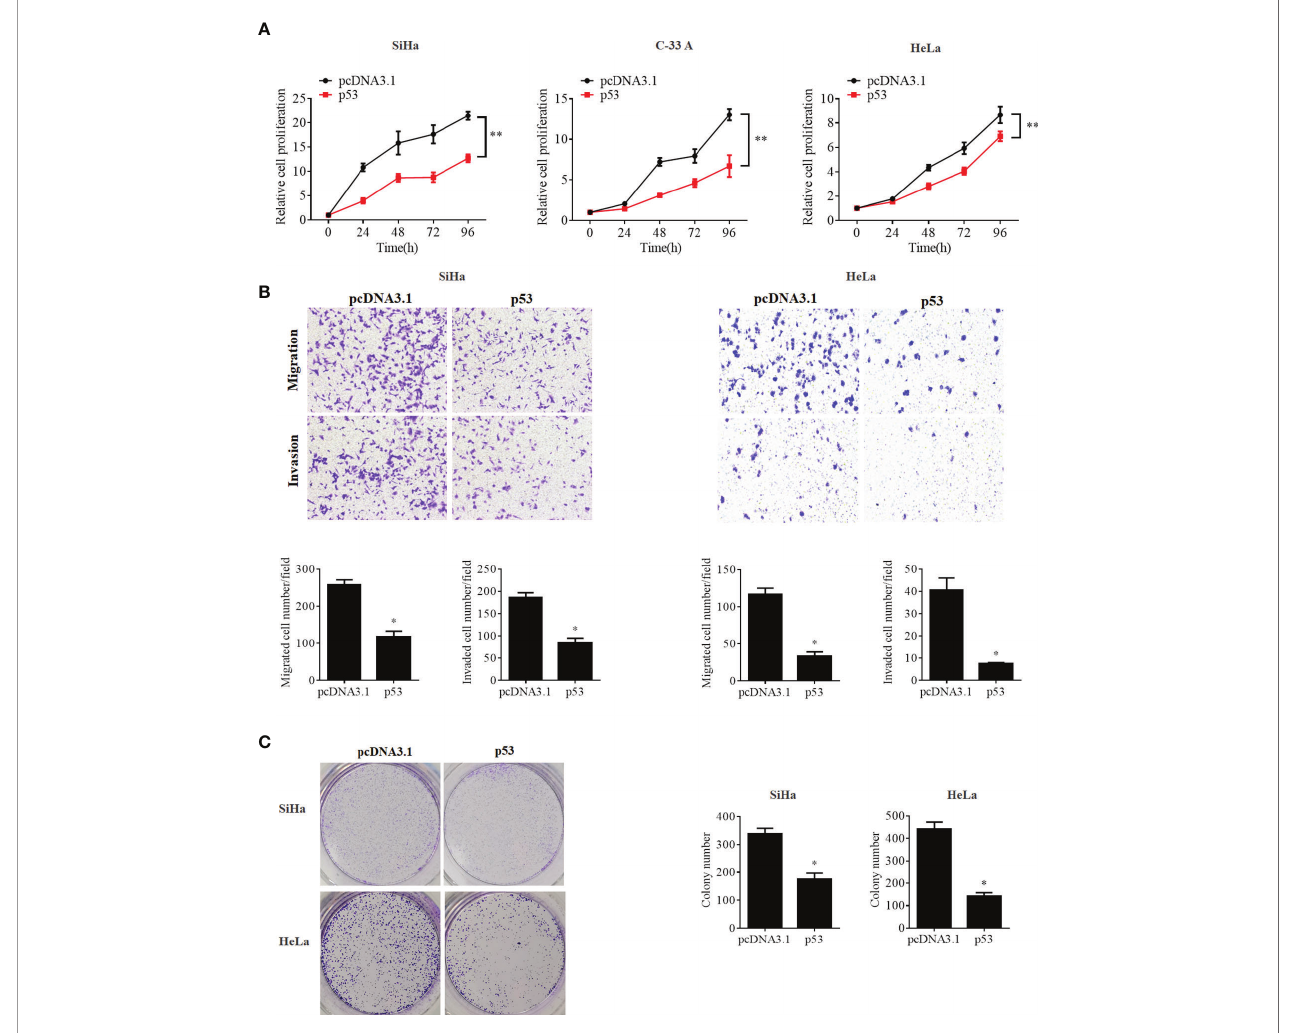
FIGURE 6 | p53 overexpression inhibited cell proliferation, migration, invasion, and colony formation potentials in human cervical cancer cells. (A) MTT assay analysis of proliferation ability in the human cervical cancer cell lines SiHa, C-33A, and HeLa transfected with pcDNA3.1-p53 or pcDNA3.1. (B) Transwell assay analysis of migration and invasion abilities in the human cervical cancer cell lines SiHa and HeLa transfected with pcDNA3.1-p53 or pcDNA3.1. (C) Representative photographs of p53 overexpression on colony formation in SiHa and HeLa cells. * p < 0.05, ** p < 0.01 vs.